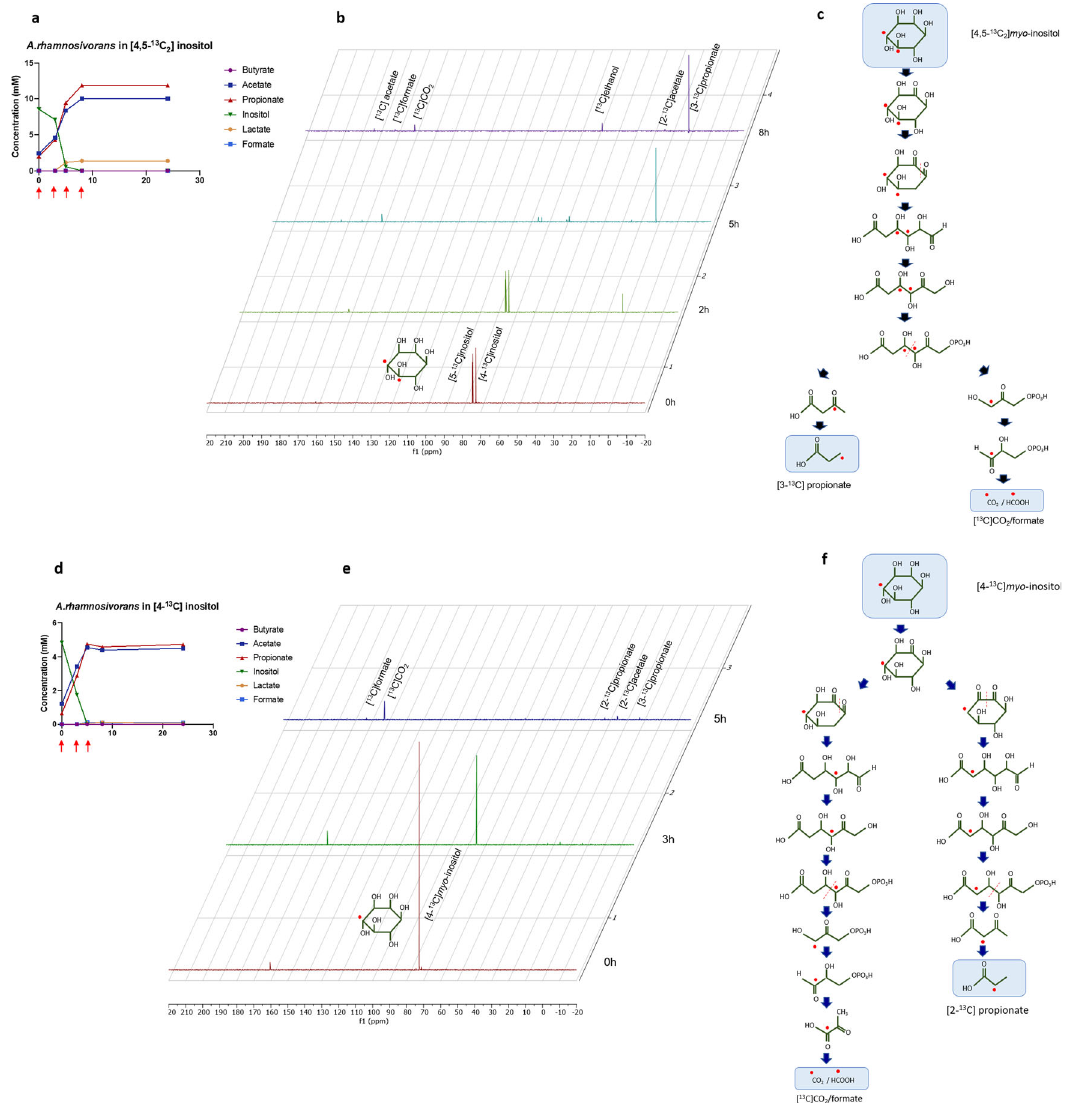
Fig. 2 Elucidation of myo -inositol pathway via 13 C-NMR analysis. High-resolution 13 C-NMR spectra showing [4,5 13 C 2 ] myo -inositol fermentation products that are [3- 13 C]propionate, [ 13 C]CO 2 , [1- 13 C]ethanol, [2- 13 C]acetate, [1- 13 C]acetate, [ 13 C]formate ( b ) with anticipated scheme of 13 C fl ow ( c ), and [4- 13 C] myo - inositol fermentation products that are [ 13 C]CO 2 , [ 13 C]formate, [2- 13 C]propionate, [2- 13 C]acetate and [3- 13 C]propionate ( e ) with anticipated scheme of 13 C fl ow ( f ). a and d show concentrations of substrate and end metabolites analysed using high performance liquid chromatography-refractive index detection (HPLC-RI) when the cells were grown in [4,5 13 C 2 ] myo -inositol and [4- 13 C] myo -inositol respectively. Red arrows indicate the samples time points for 13